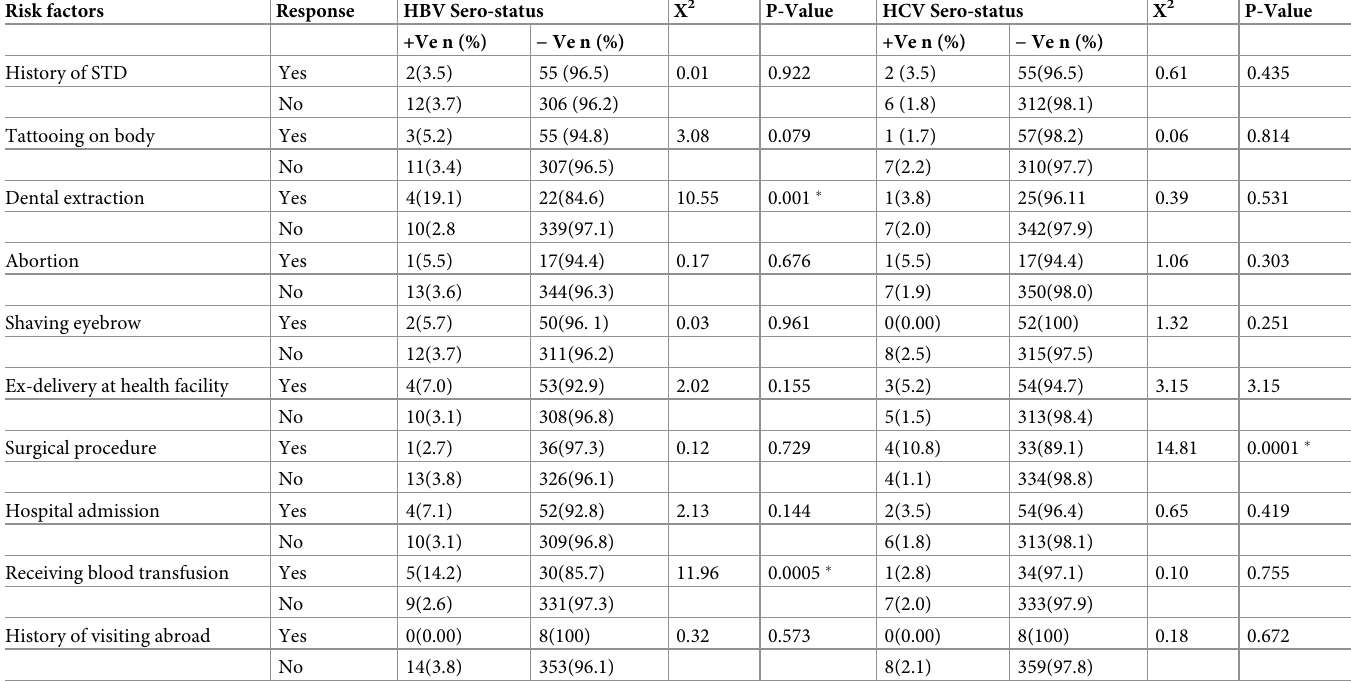
Table 1. HBV and HCV associated risk factors among pregnant women attending maternity wards at selected Hospitals, DHQ Hospital Swabi and BKMC